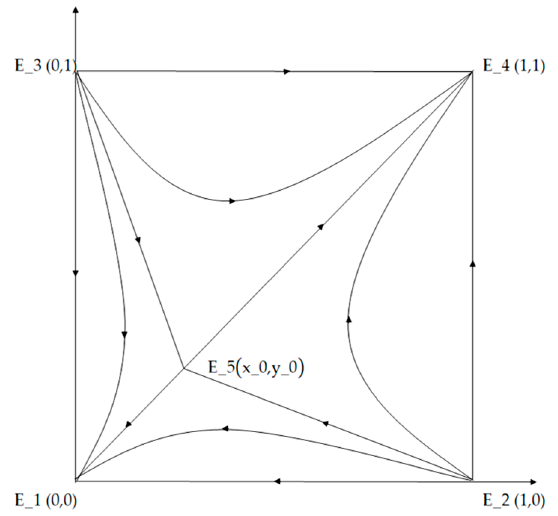
Figure 3. Phase diagram of the dynamic evolution of a five-equilibrium system. Note: E_1 means both large and small companies take strategies of safety investment. E_2 means large companies take strategies of food fraud and small companies take strategies of safety investment. E_3 means large companies take strategies of safety investment and small companies take strategies of food fraud. E_4 means both large and small companies take strategies of food fraud. E_5 ( x_0,y_0 ) is the initial state of large and small